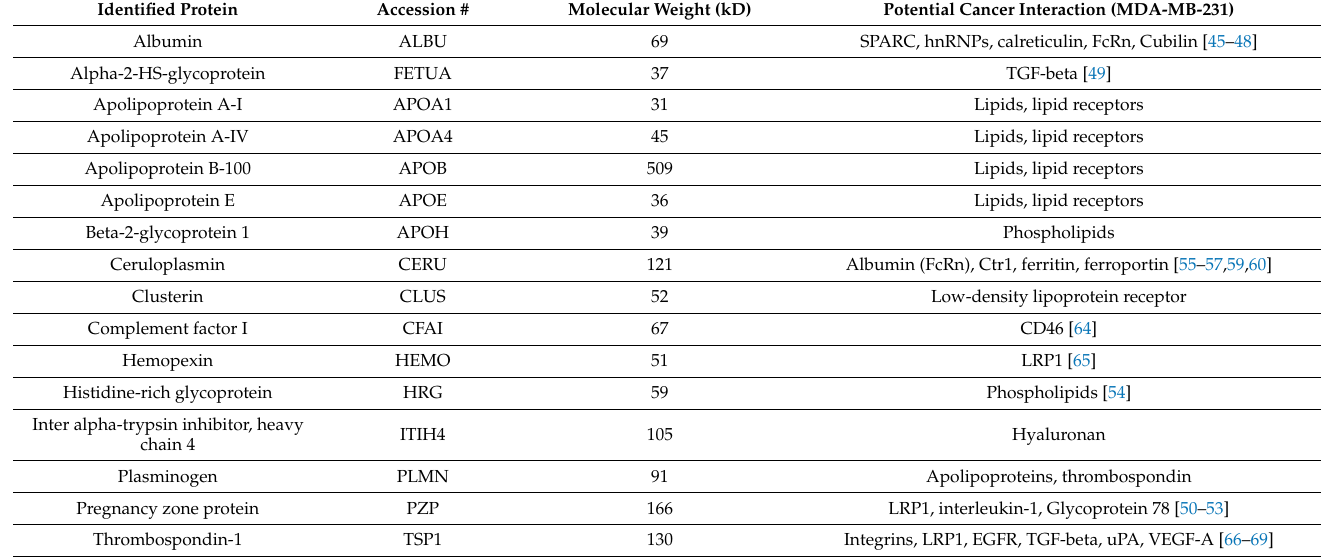
Table 4. List of most abundant proteins absorbed by HBPE-NPs treated with VS5 that had potential cancer cell interactions based on data from known ligands, MDA-MB-231 cells (https://www.uniprot.org/, https://www.kobic.kr/GEMICCL/), or reviewing the literature. Abundance was determined from spectral counts normalized to the total number of spectra in sera samples (Normalized Total Spectra).